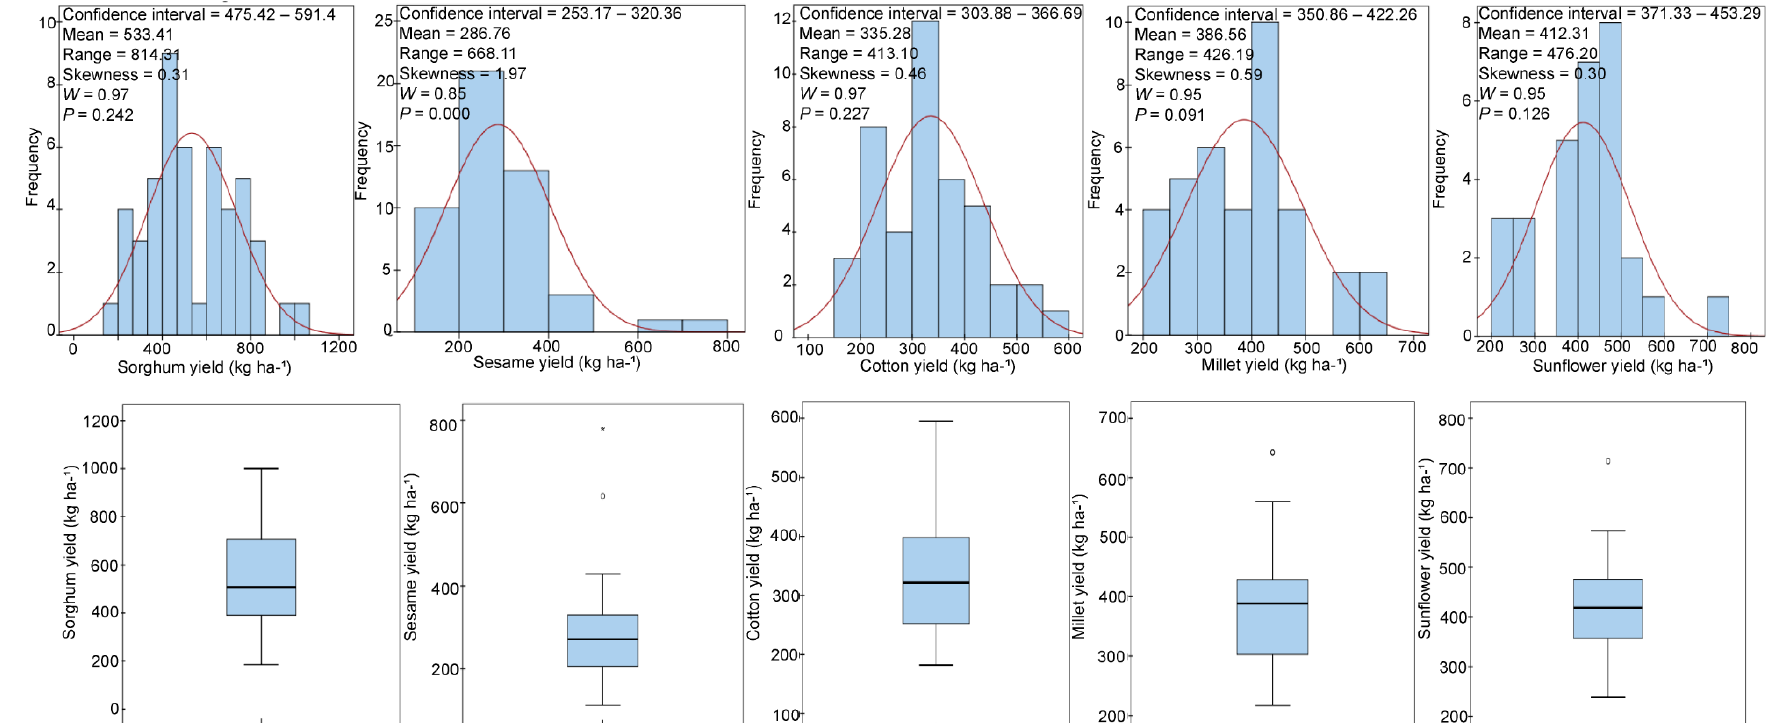
Figure A2. Histogram, normal distribution, and boxplot fitted for crop yield data obtained from the Ministry of Agriculture, Gedaref, Sudan. The crop yield data were collected in 1970–2018, except for millet and sunflower, which were only available between 1982–2018 and 1987–2018, respectively. Circles in some boxplots represent individual outlier observations.